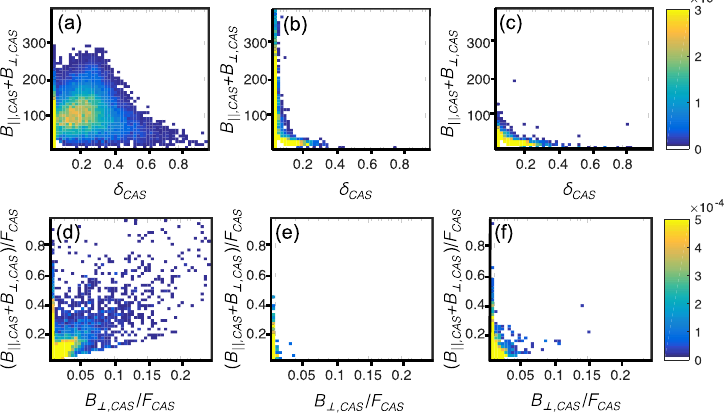
Figure 1. Optical signatures of training data populations: ice crystals (a, d) , droplets (b, e) , and aerosol (c, f) . The CASPOL signals used to generate these signatures are parallel back scatter ( B || CAS ) , perpendicular back scatter ( B ⊥ , CAS ) , and forward scatter ( F CAS ) . The shading scales indicate the fraction of the training dataset that populates a grid